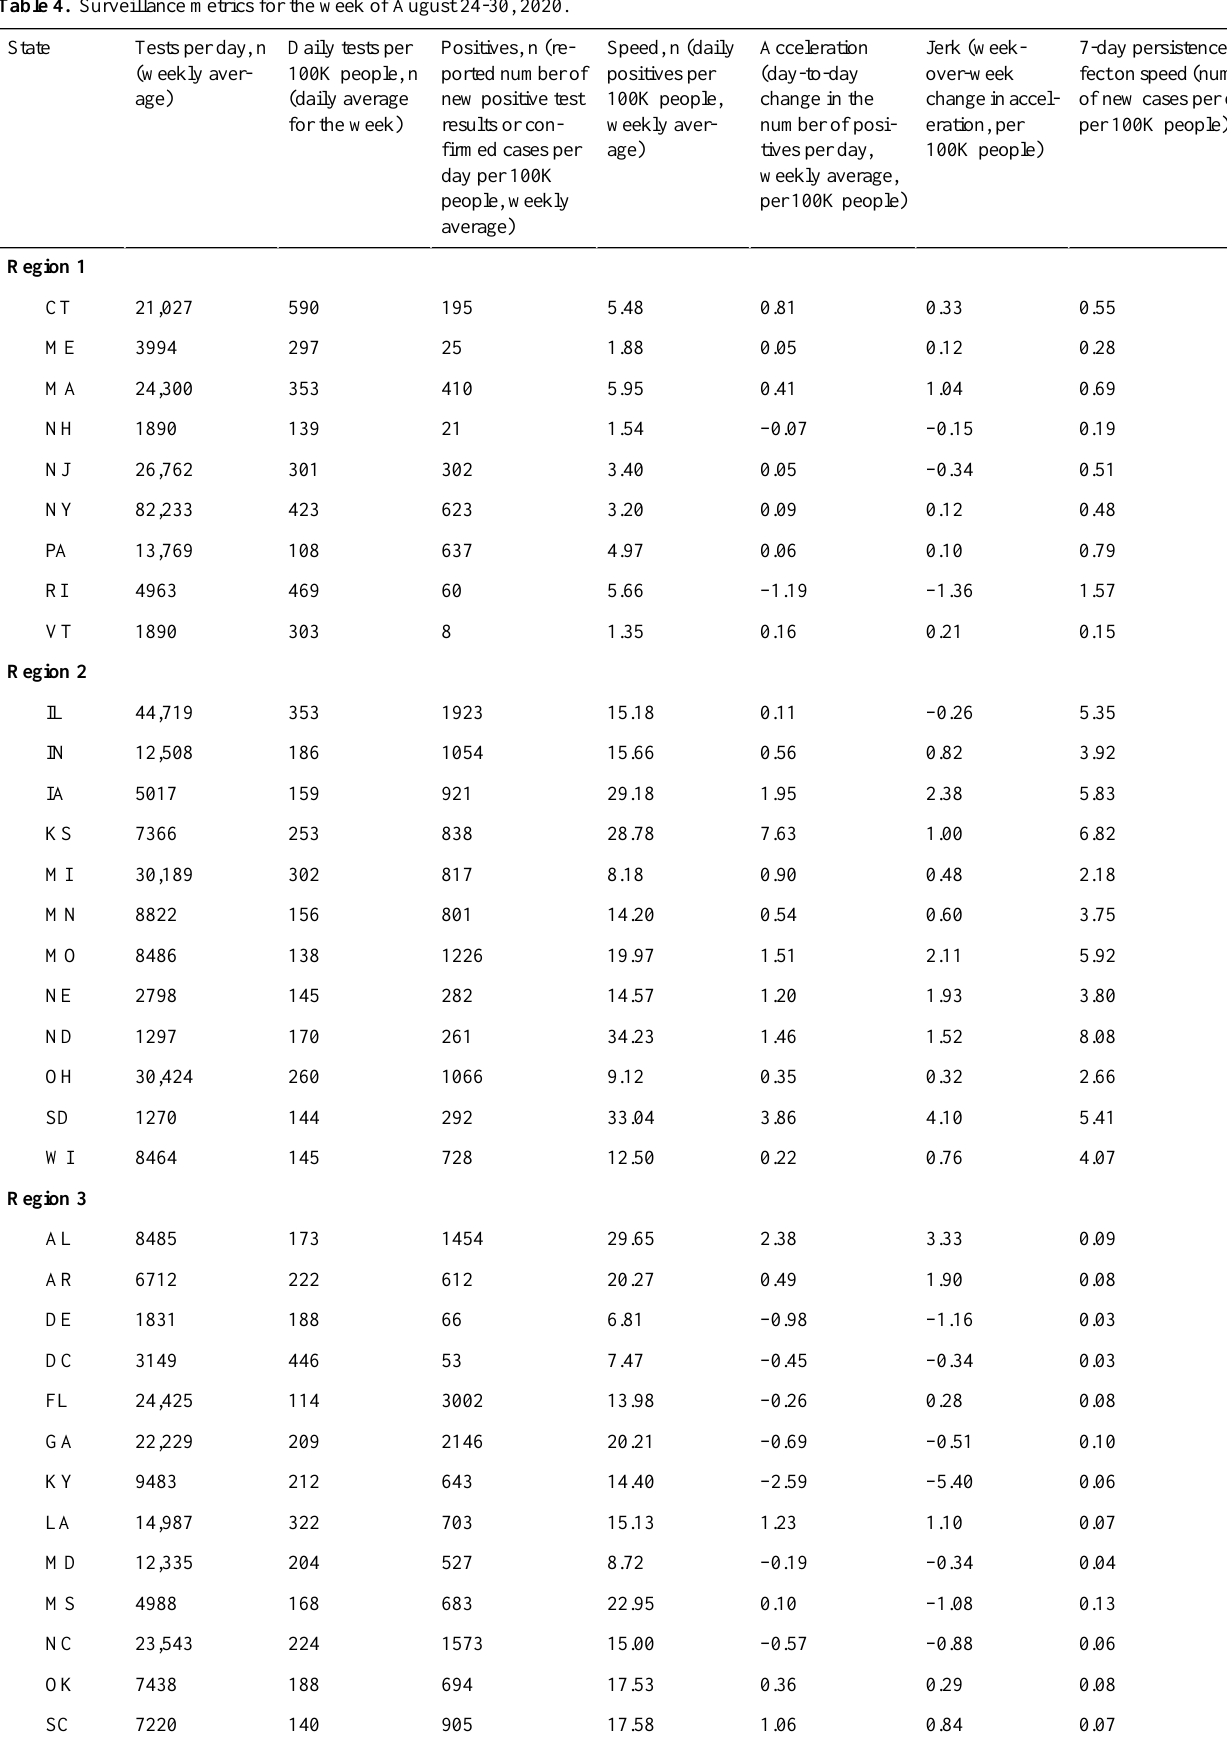
Table 4. Surveillance metrics for the week of August 24-30,